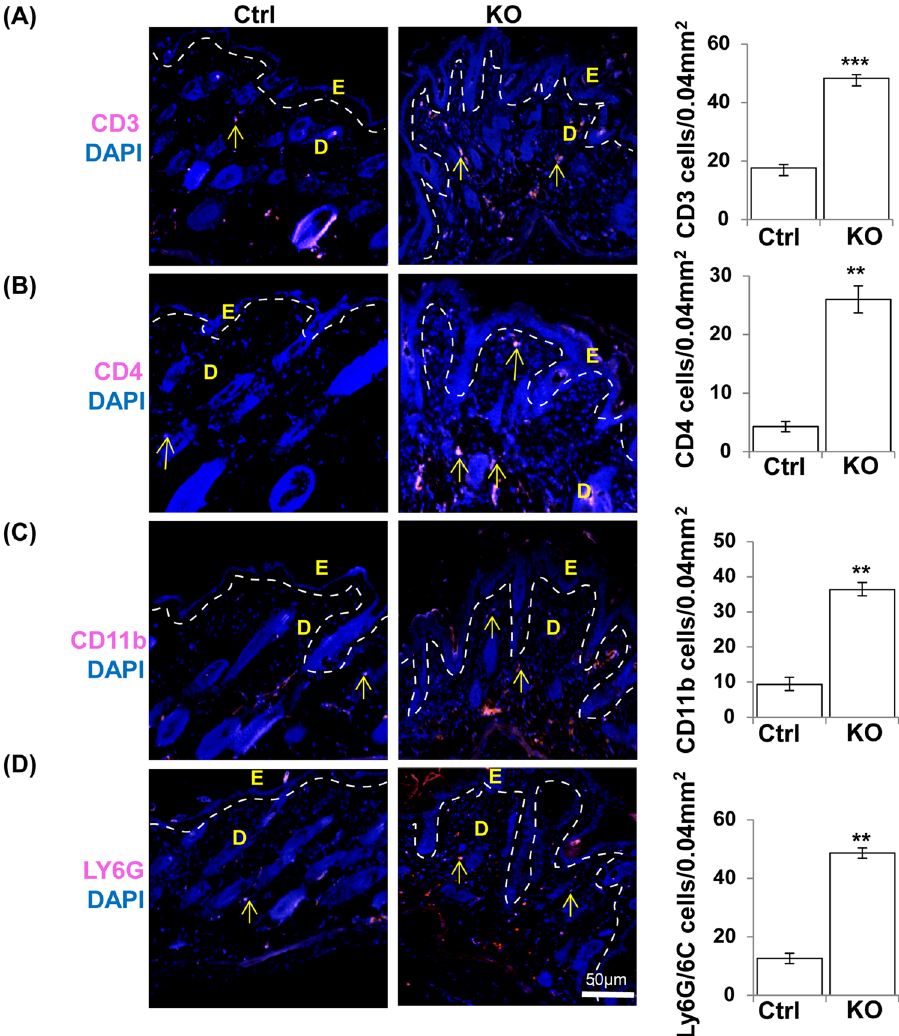
Figure 7. Increased CD3, CD4, CD11b and Ly6G/ly6C cells in the skin of N-WASP K14KO mice. Immunostaining showed that CD3 (A) , CD4 (B) , CD11b (C) and Ly6G/ly6C (D) immune cells are significantly increased in dermal skin of N-WASP K14KO mice compared to control mice on 23 rd day. ( ↑ ) indicates CD3, CD4, CD11b and Ly6G/ly6C cells. Results are mean ± SEM *** p < 0.001, ** p < 0.01. (n =